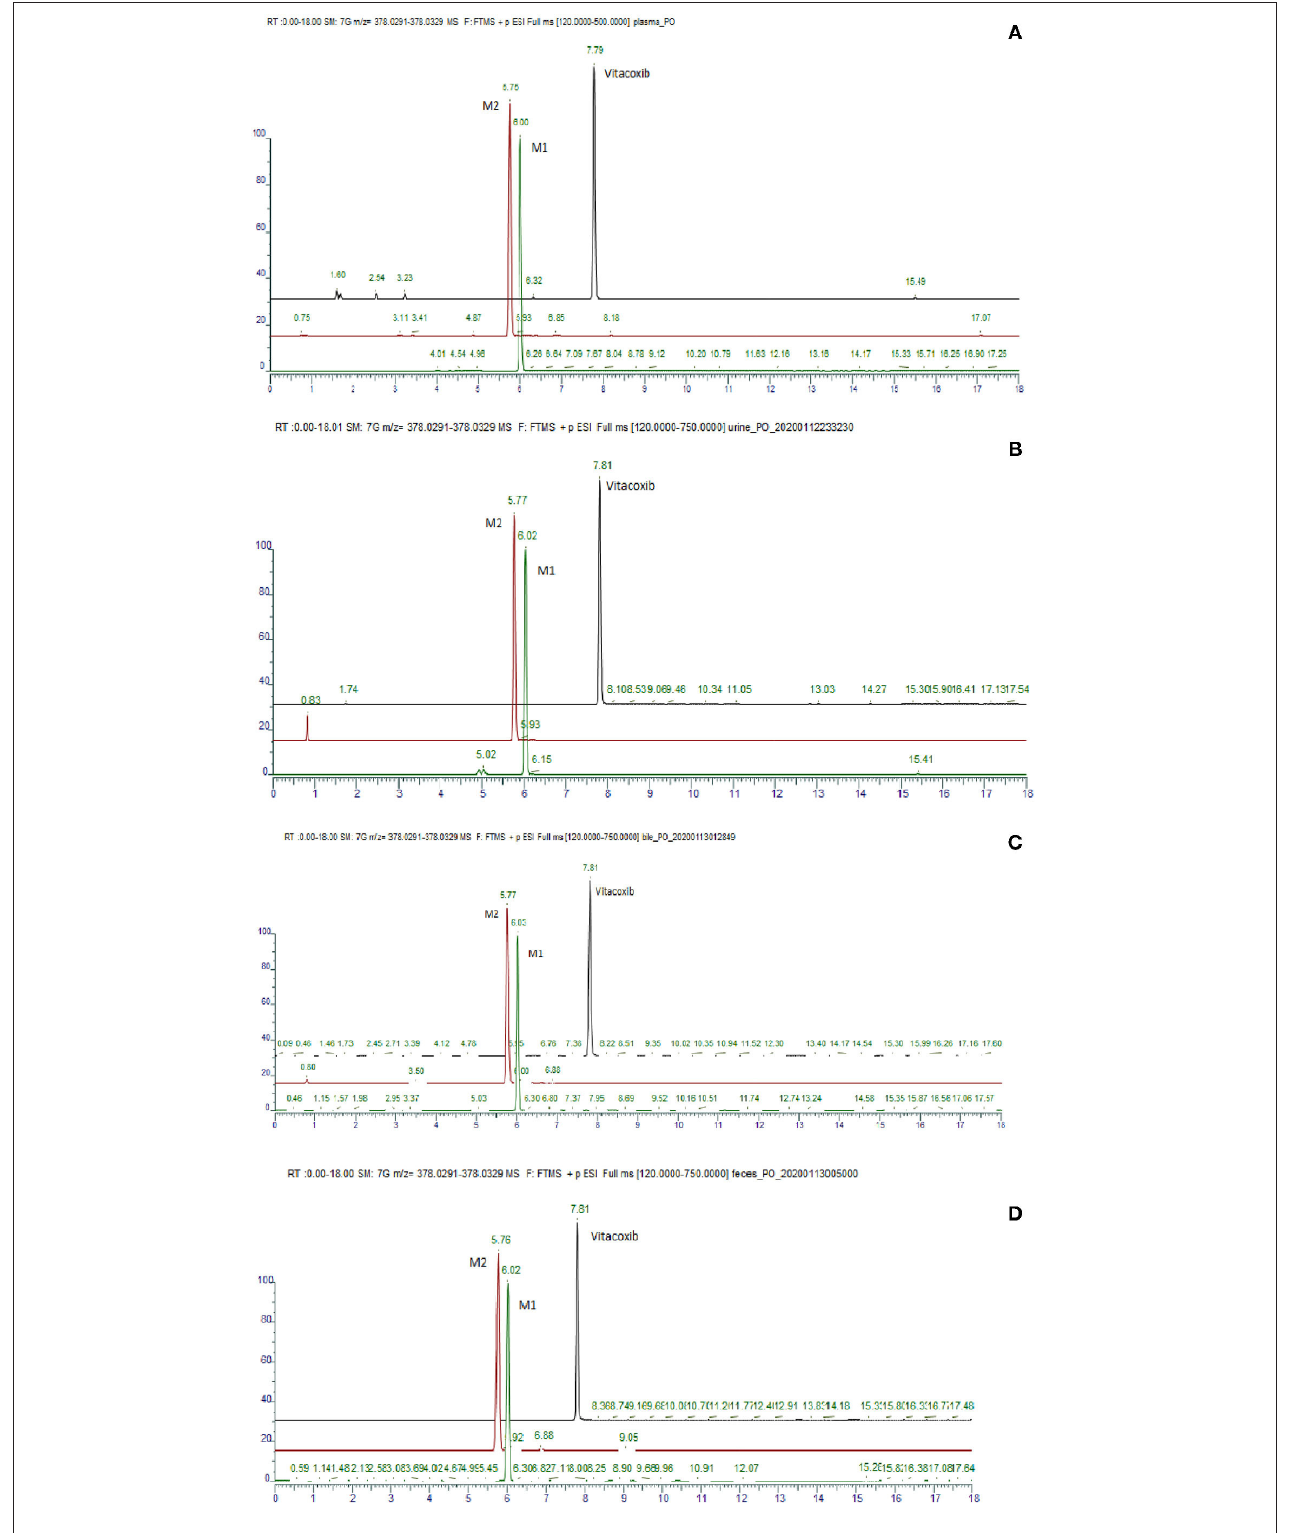
FIGURE 7 | Typical ion chromatogram obtained from the analysis of the pool of plasma (A) , urine (B) , bile (C) and feces (D) .